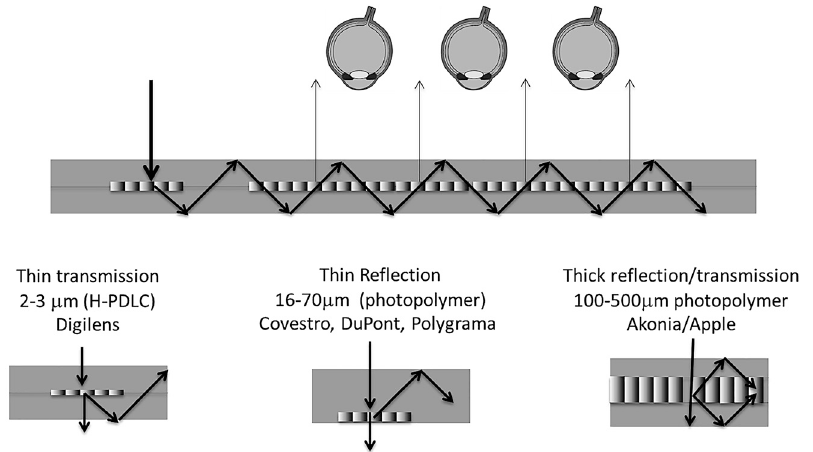
Figure 11: Different types of volume holograms acting as in-couplers and out- couplers in waveguide combiners.